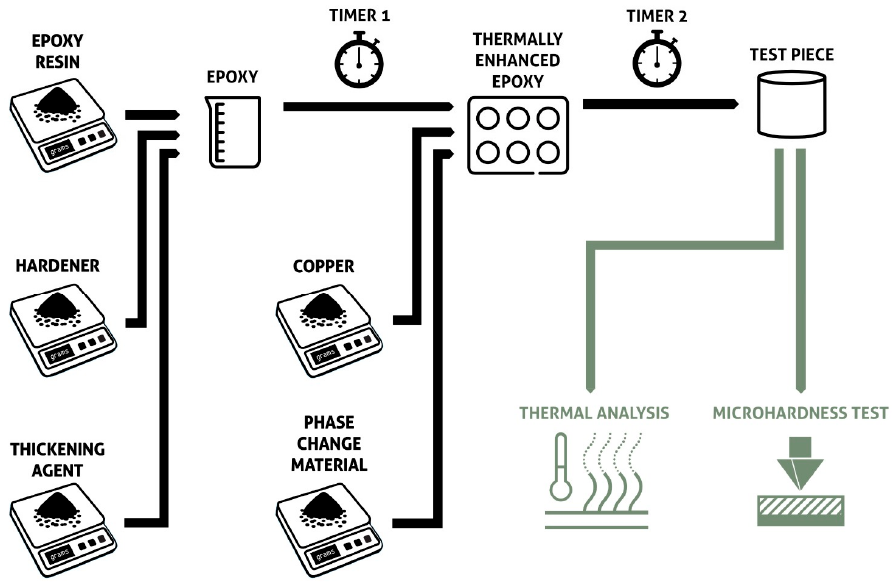
Figure 1. Schematic diagram of the preparation steps and techniques used for the analysis of the composites. the